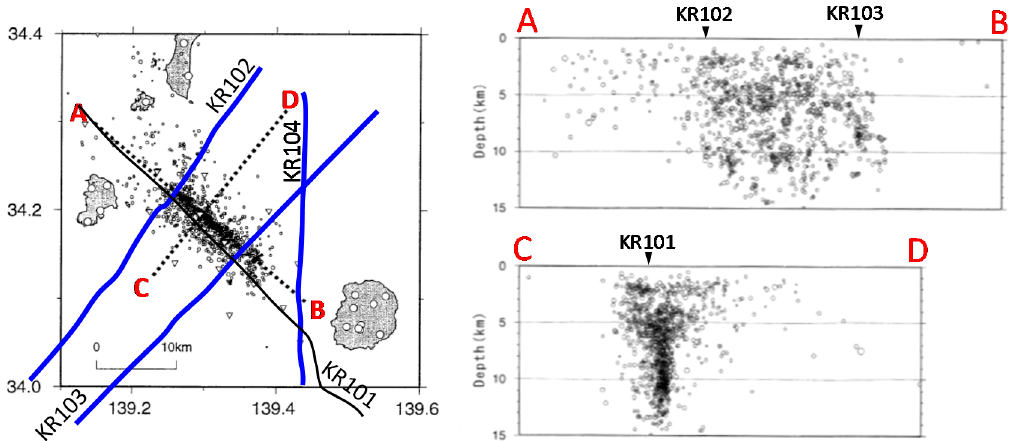
Figure 2. Hypocenter distribution of the earthquake swarm in 2000 [4] and seismic lines in Figure 1. The hypocenters determined by both land stations and Ocean Bottom Seismometers (OBSs) in 2000 are shown in the left side map. The four seismic lines were overlaid on the map. The right figures represent the hypocenters projected to the cross sections of A,B and C,D, indicating a dike intrusion of magma associated with the 2000 eruption of Miyakejima Volcano [5].